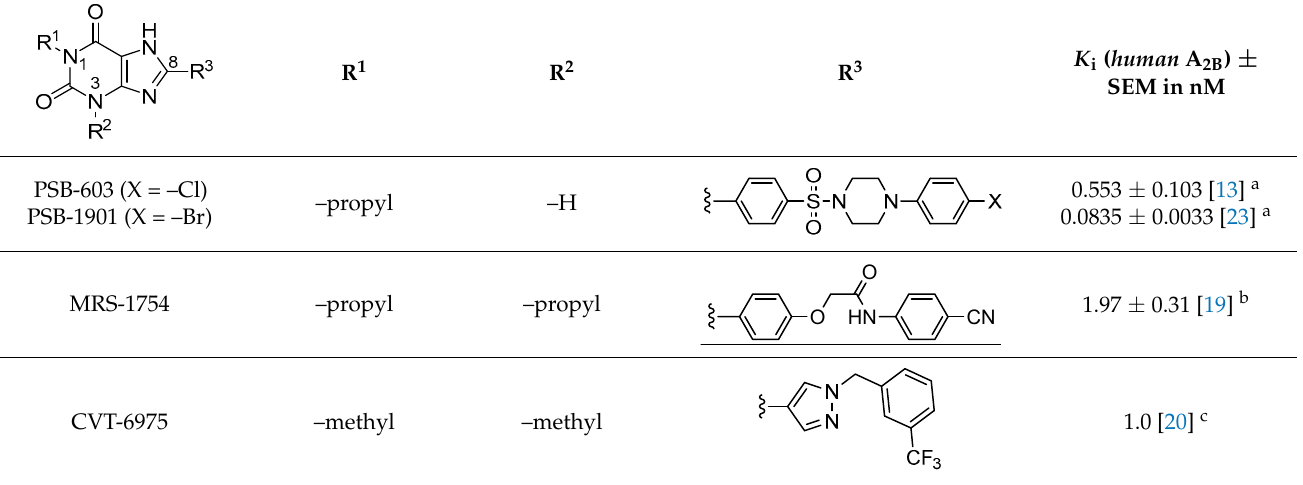
Table 1. Known high-affinity xanthine-based ligands for the A 2B receptor (all selectivity ratios K i (A x )/ K i (A 2B ) >210).